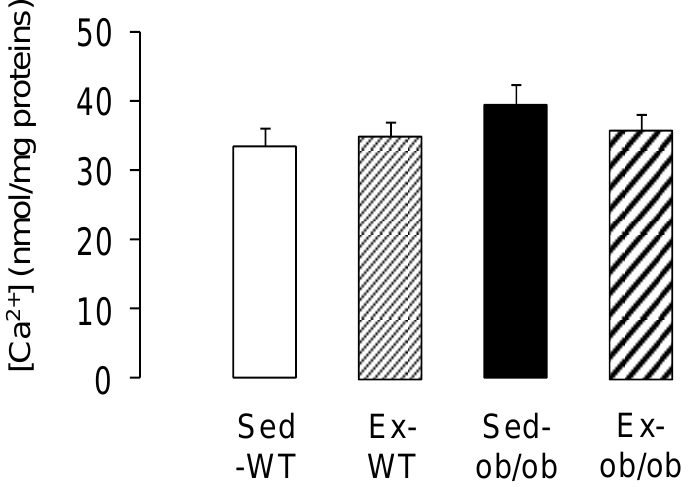
Figure 5. Mitochondrial Ca2+ retention (index of mPTP opening) in wild-type (WT) and ob/ob mice in sedentary conditions (Sed, n = 11 and 10, respectively) or after regular exercise (Ex, n = 11 and 10, respectively). Values are expressed as mean ± SEM.